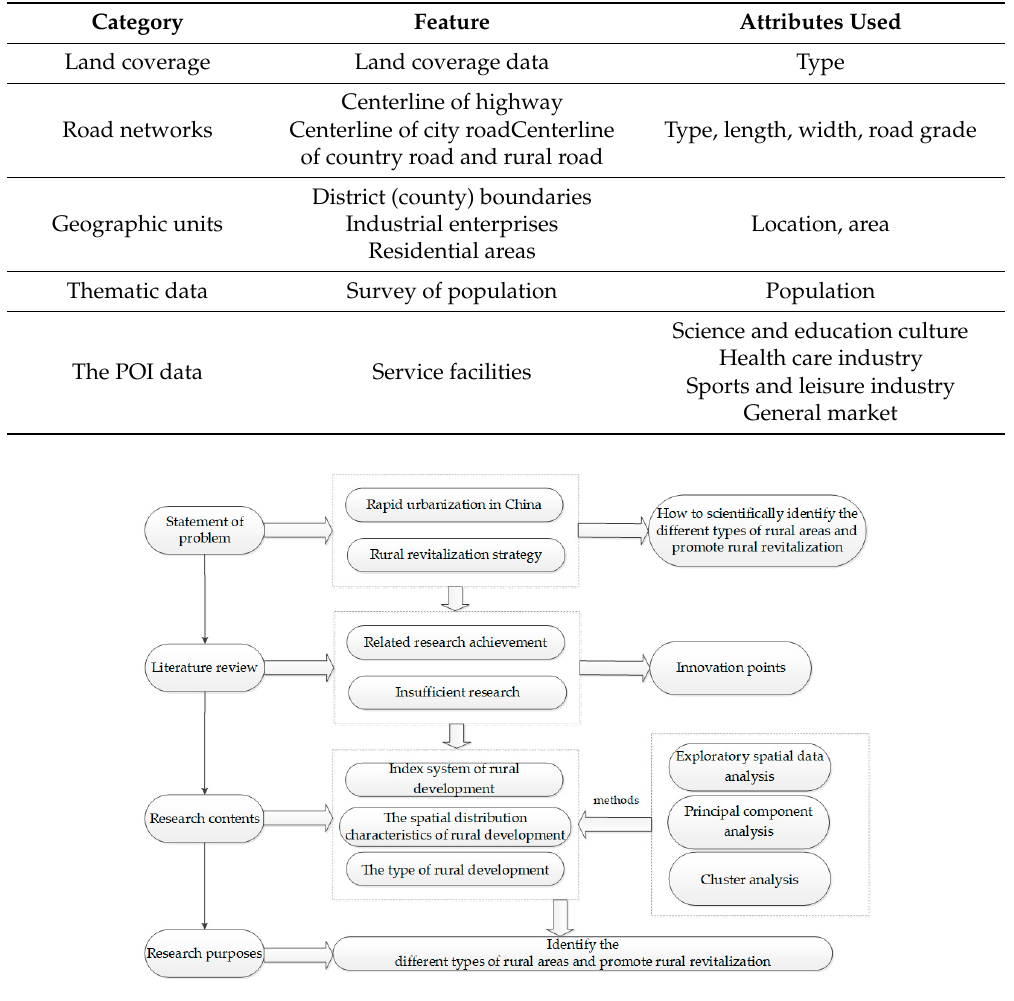
Figure 3. Technology roadmap.